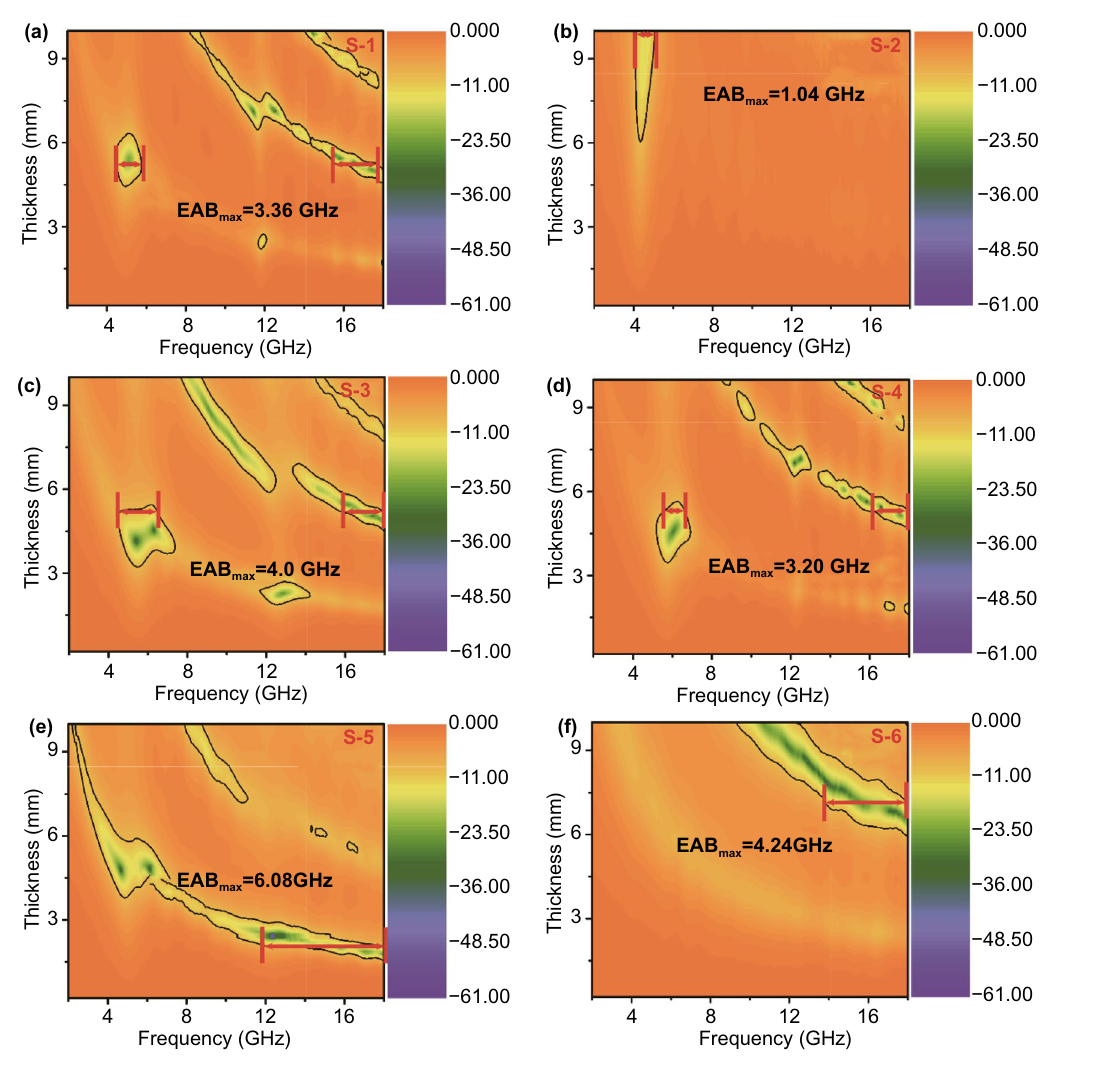
Fig. 6 2D reflection loss diagram of a S-1, b S-2, c S-3, d S-4, e S-5, f